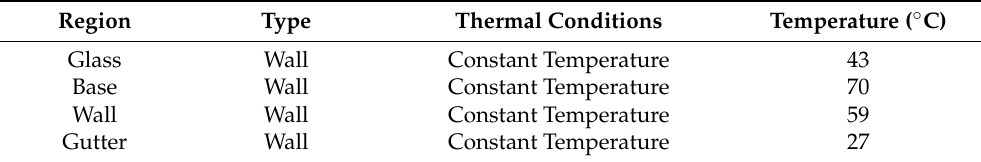
Table 7. Boundary conditions used in the CFD simulation.